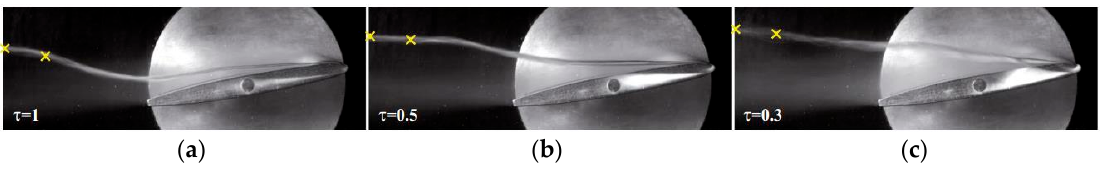
Figure 7. TLV Cavitation visualizations during 11 ms for three tip clearances. The two crosses are the locations z/c = 1 and 1.2 [14]. ( a ) τ = 1; ( b ) τ = 0.5; ( c ) τ = 0.3.